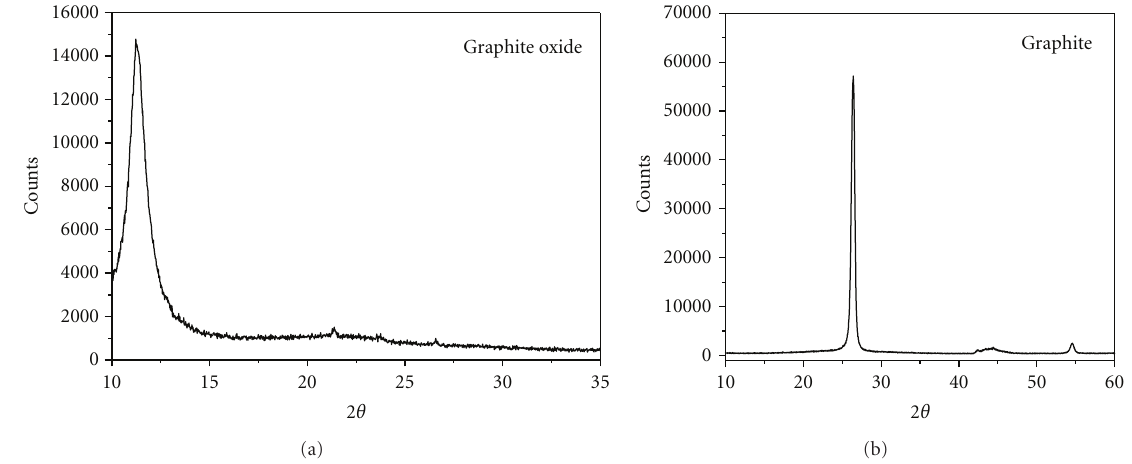
Figure 1: X-ray spectrum of graphite oxide (a), graphite powder (b).